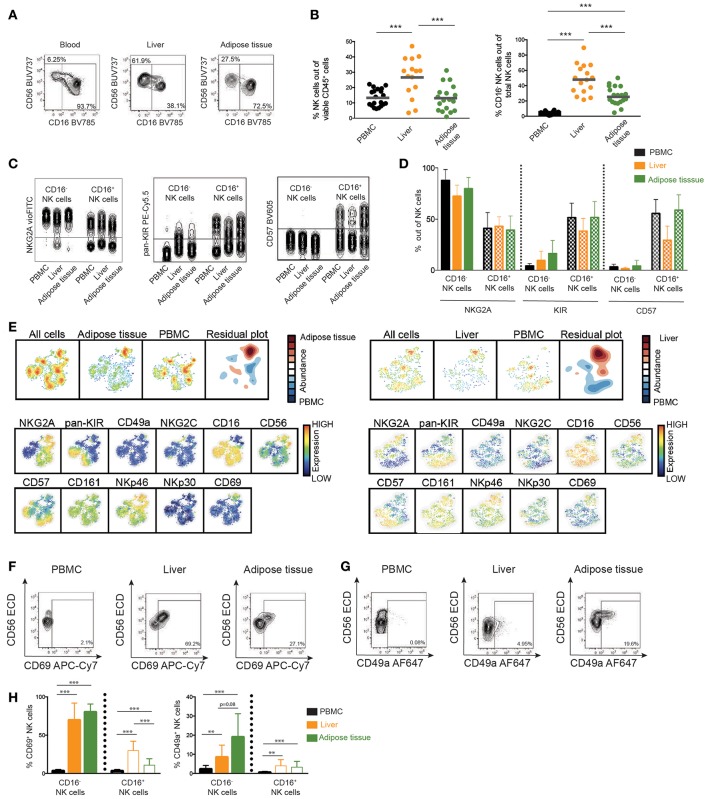
Phenotype of NK cells in liver and adipose tissue. (A) Representative flow cytometry plots of NK cells derived from blood, liver, and adipose tissue. (B) Scatter plot of the frequency of total NK cells out of viable leukocytes and CD16− NK cells out of total NK cells in peripheral blood, liver, and adipose tissue. PBMC (n = 22), adipose tissue (n = 19), and liver (n = 15). (C) Representative concatenated flow cytometry plots showing expression of differentiation markers NKG2A, KIRs, and CD57 on CD16− or CD16+ NK cells in blood, liver, and adipose tissue. (D) Bar graphs showing frequency of cells expressing the indicated differentiation markers in CD16− or CD16+ NK cells from blood, liver, and adipose tissue. PBMC (n = 22), adipose tissue (n = 19), and liver (n = 15). (E) SNE plot of total NK cells from adipose tissue (left) or liver (right) compared to peripheral blood. The residual plot highlights the decreased (blue) or more highly expressed (red) areas within tissue NK cells. (F,G) Representative flow cytometry plots showing CD69 and CD49a expression on total NK cells from the indicated tissues. (H) Expression of CD69 and CD49a on CD16− and CD16+ NK cells in peripheral blood, liver, and adipose tissue. In H, CD69 on PBMC (n = 22), adipose tissue (n = 18), and liver (n = 15), CD49a on PBMC (n = 9), adipose tissue (n = 9), and liver (n = 7). Bars in (B,D,H) represent mean and error bars in (D,H) show SEM. **p < 0.01, ***p < 0.001.